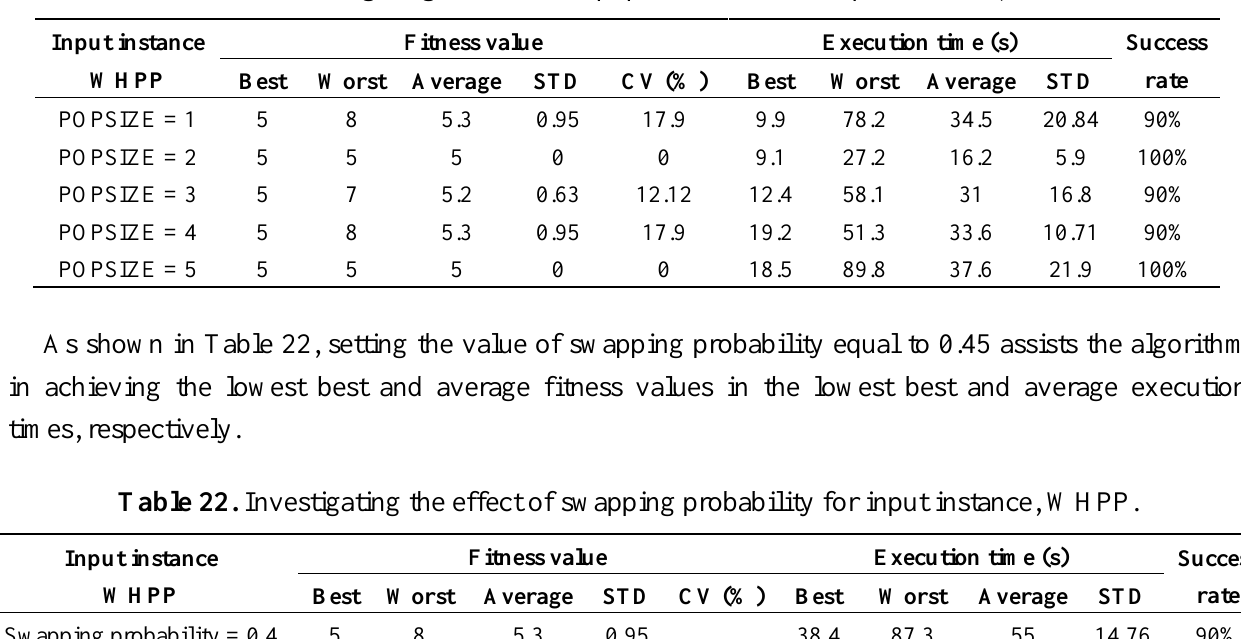
Swapping probability = 0.4